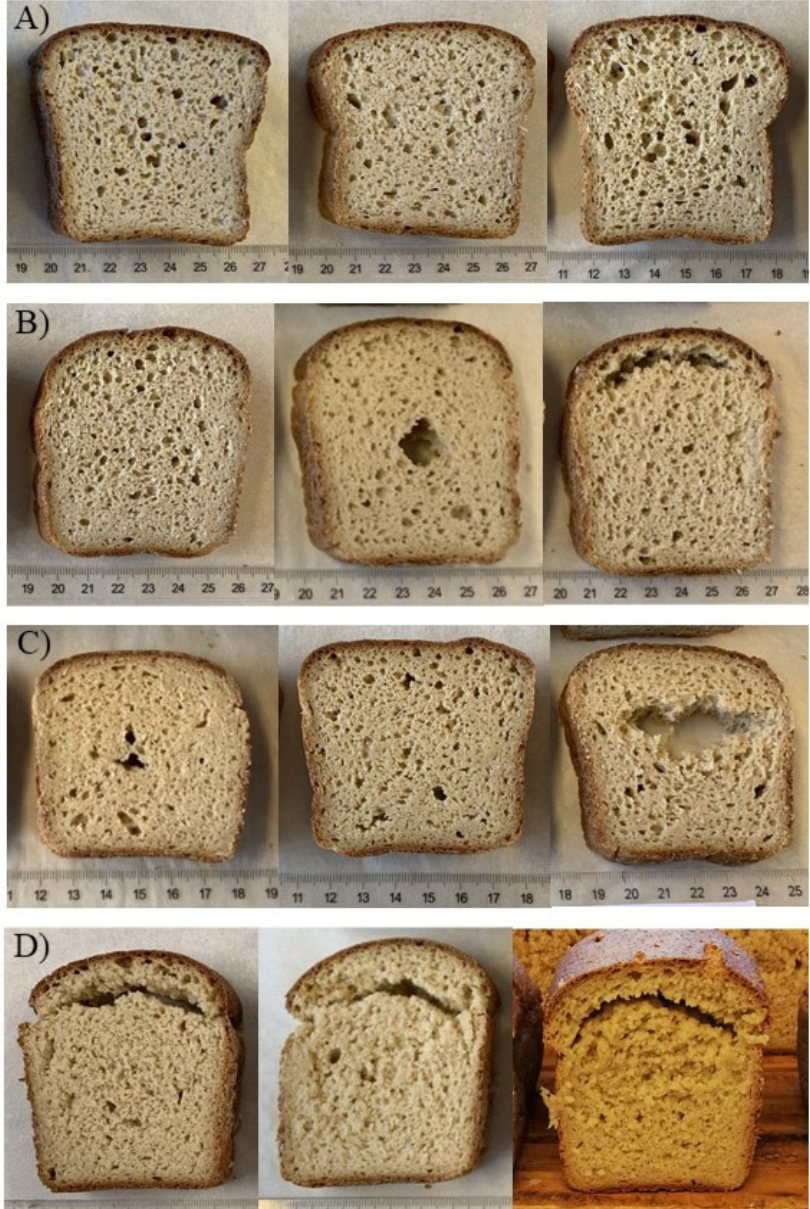
Figure 2. ( A ) The breads from three oat cultivar samples baked at optimal dough yield of 205. ( B ) Oat cultivar sample (F28) baked at dough yields 197, 200, and 205, from left to right. ( C ) Oat cultivar sample (F21) baked at dough yields 185, 192, and 200, from left to right. ( D ) Oat cultivar sample (F23) baked at dough yields 185, 190, and 195, from left to right.